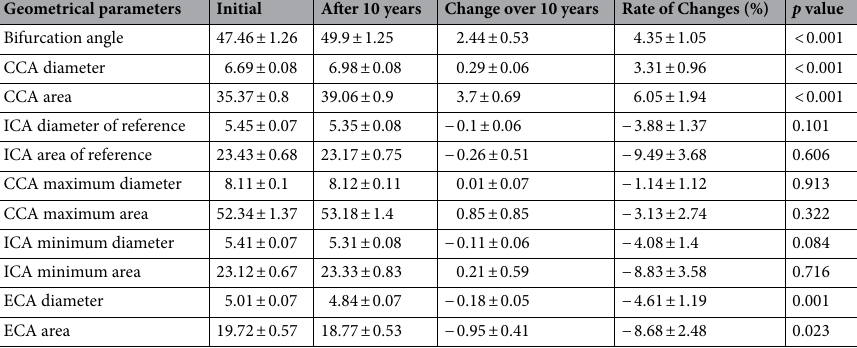
Table 2. Geometric changes in the right carotid artery from baseline and after 10 years of follow-up. CCA common carotid artery, ICA internal carotid artery, ECA external carotid artery.